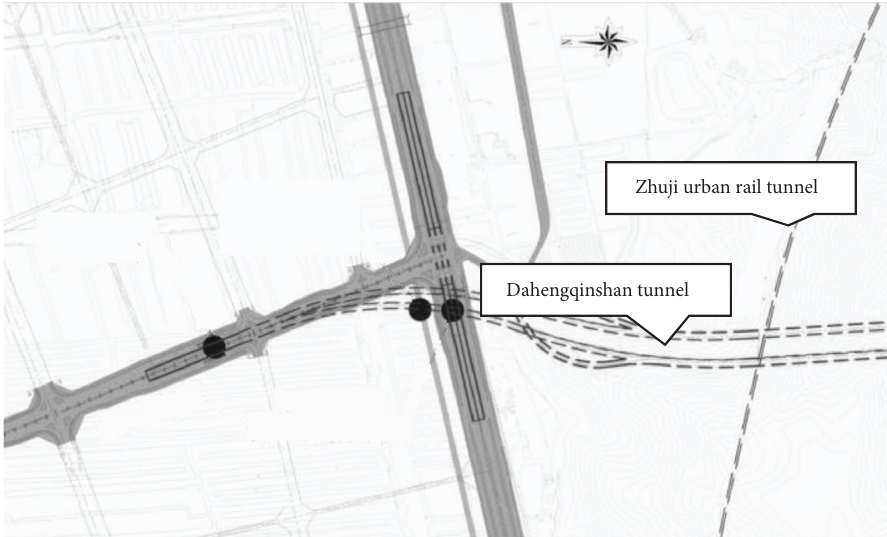
Figure 1: Plane position relationship between Dahengqinshan Tunnel and Zhuji Tunnel.